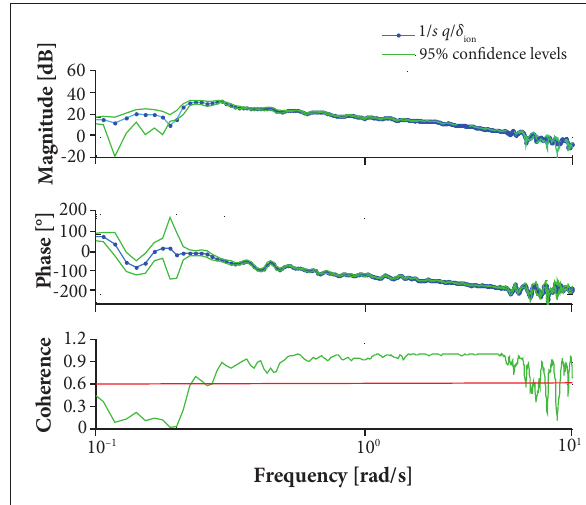
Figure 11. Bode diagram and coherence function for longitudinal cyclic input.